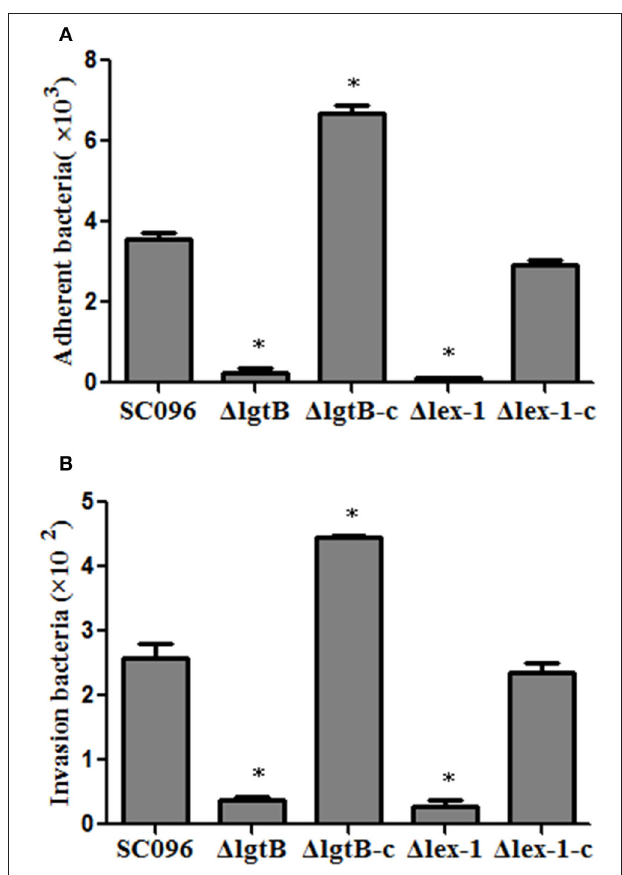
FIGURE 6 | Adherence (A) and invasion (B) of H. parasuis wild-type SC096, 1 lgtB and 1 lex-1 mutants and complemented strains in PK-15 cells. The data represented the number of bacteria that adhered to or invaded the cells in each well of a 24-well plate. Error bars represent the standard deviation from three independent experiments performed in triplicate. The asterisks indicate that the number of bacteria bound to the PK-15 cells was statistically different ( p < 0.01) from that of the wild-type SC096 strain as judged by the Student t-